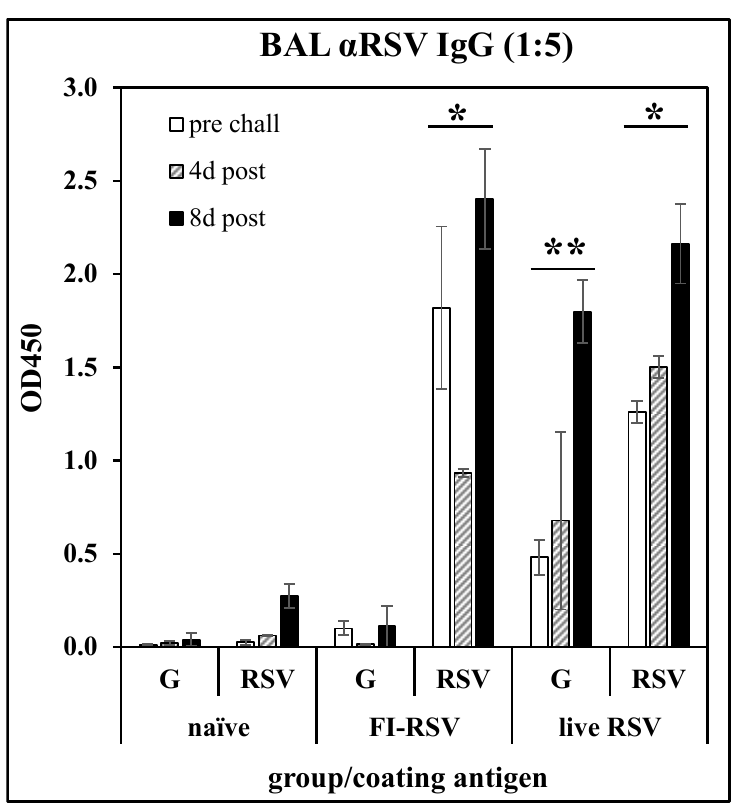
Figure 1. Antibody responses in BAL fluid of mice immunized with FI-RSV or convalescent from RSV infection. BALB/c mice were immunized with FI-RSV on days 0 and 21, with RSV on day 0, or not treated (naïve), then challenged with RSV on day 35. BAL fluid was collected on day 28 (pre-challenge) and 4- or 8-days post-challenge and IgG antibody responses were measured by ELISA against G 169-198 peptide (G) or whole RSV. Mean ± SEM of 3 mice per group at 1:5 BAL fluid dilutions. * p < 0.05 compared to naïve BAL fluid tested against RSV at each time point; ** p < 0.05 compared to naïve BAL fluid tested against G 169-198 peptide at each time point by t-test.